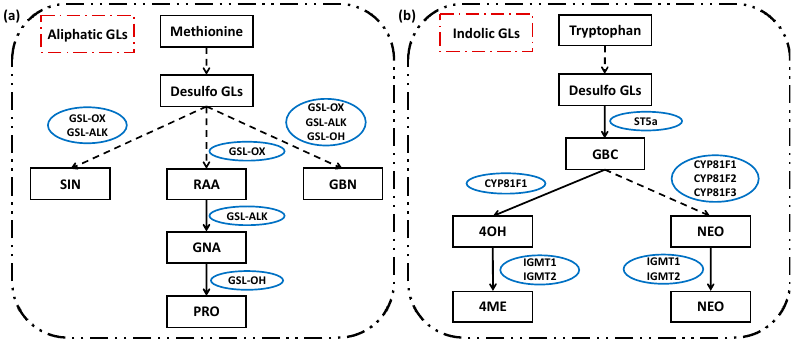
Figure 7. The simplified framework of aliphatic and indolic glucosinolate biosynthesis (modified based on Augustine et al. [79]). ( a ) Methionine-derived aliphatic glucosinolate and ( b ) Tryptophan- derived indolic glucosinolate. PRO = progoitrin, RAA = glucoraphanin, SIN = sinigrin, GNA = gluconapin, GBN= glucobrassicanapin, 4OH = 4-hydroxyglucobrassicin, GBC = glucobrassicin, 4ME = 4-methoxyglucobrassicin, NEO = neoglucobrassicin.